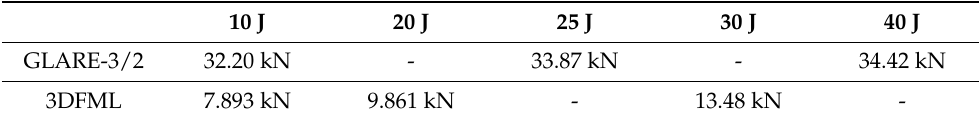
Table 4. Reduction in residual compressive load capacity for GLARE and 3DFML corresponding to the tested energy